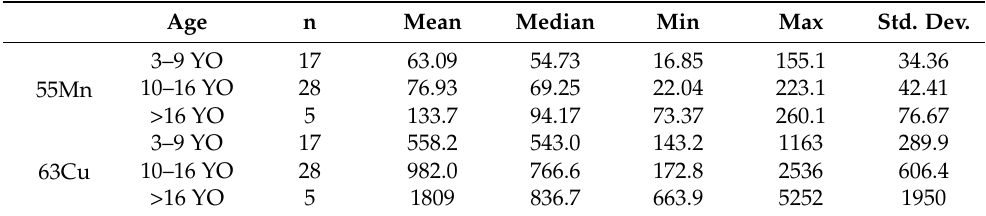
Table 4. Contents of selected elements (with statistically significant differences) in the measured Scottish Single Malt Whisky (n = 50) [ µ